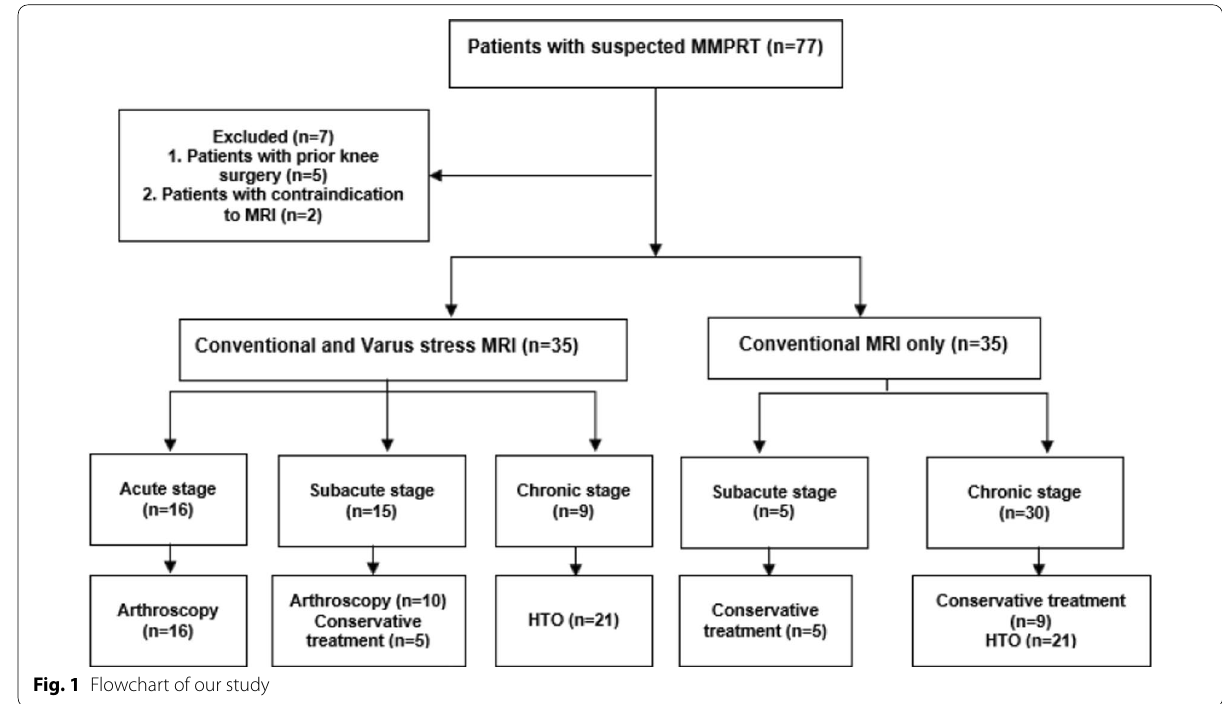
Table 1 Protocol for MRI examination of knee joint and meniscus Sequences